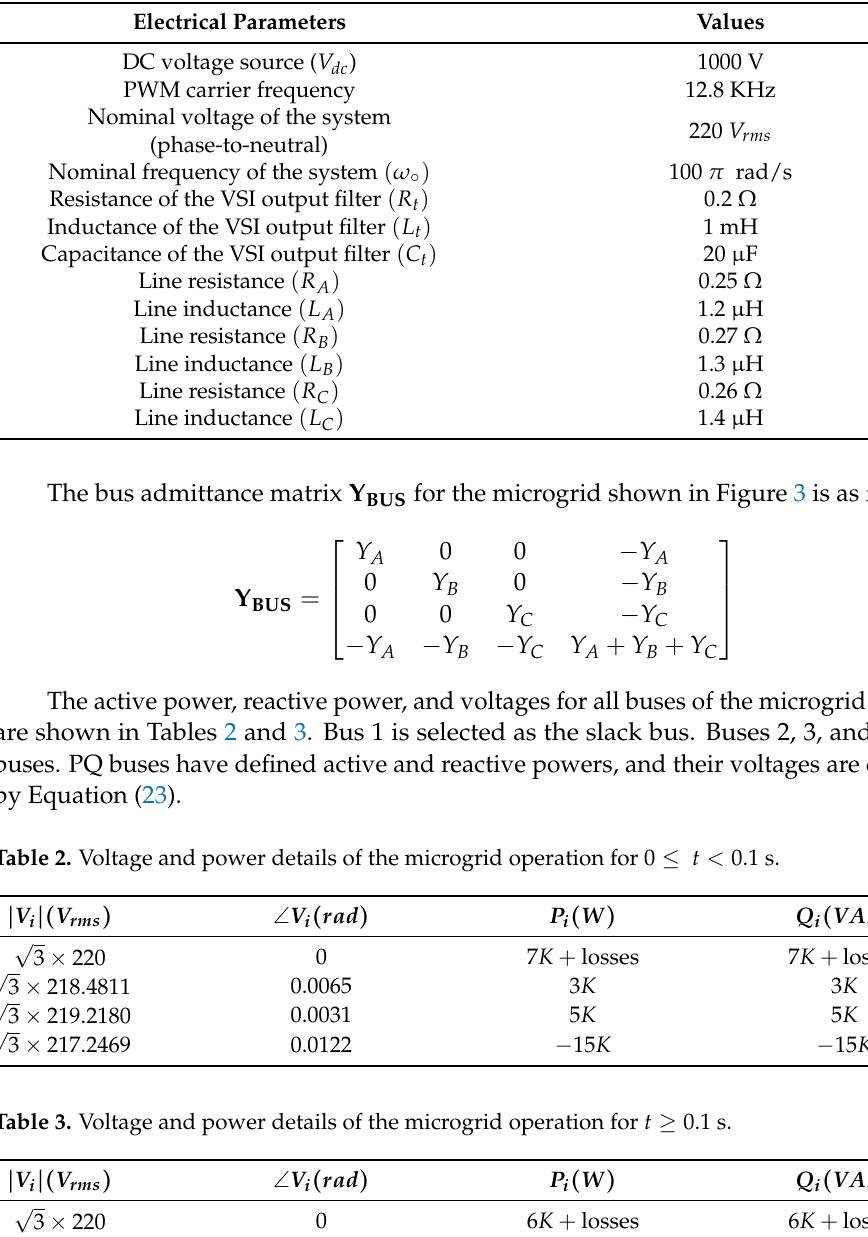
Table 1. Electrical parameters of the microgrid.